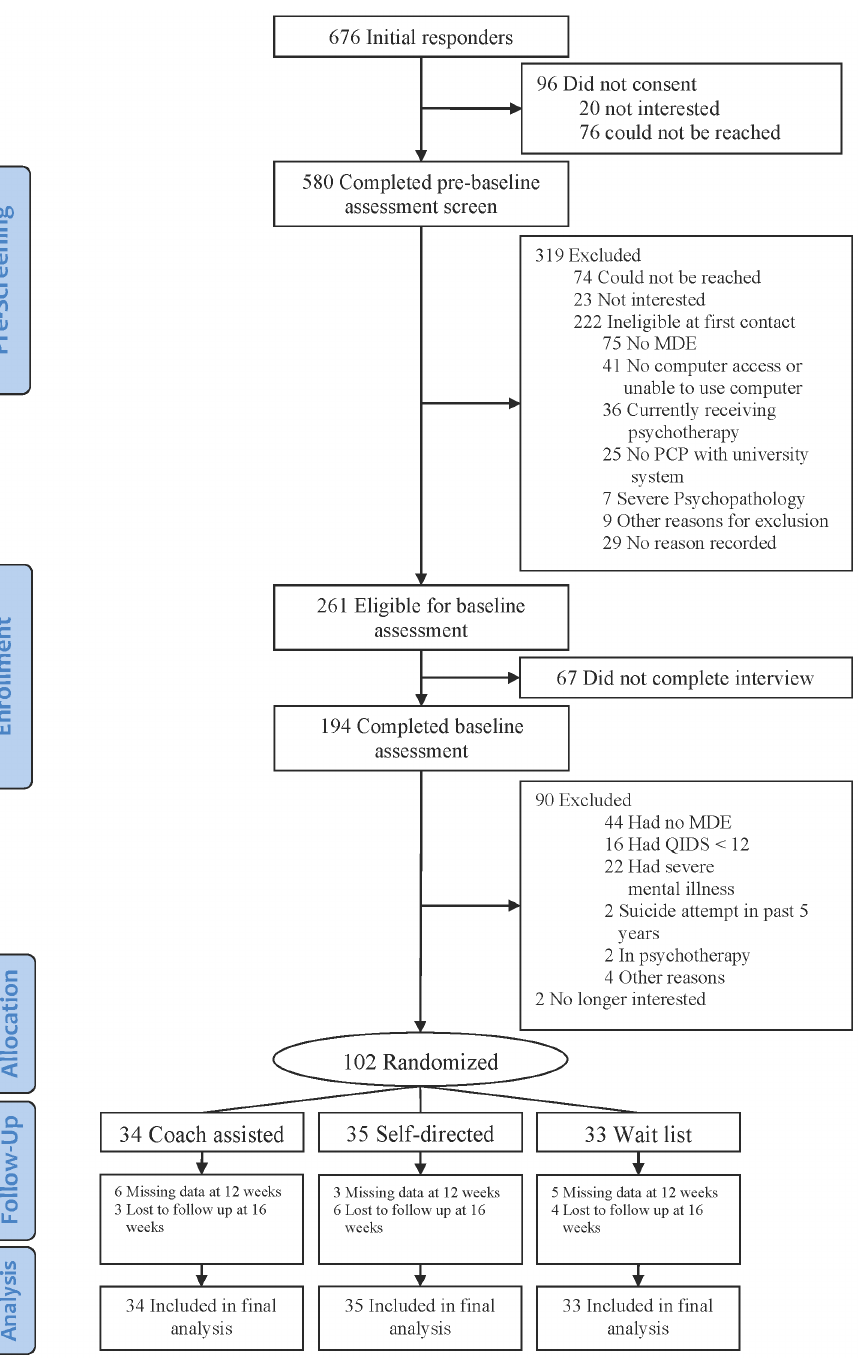
Figure 1. Flow of study participants through the trial.